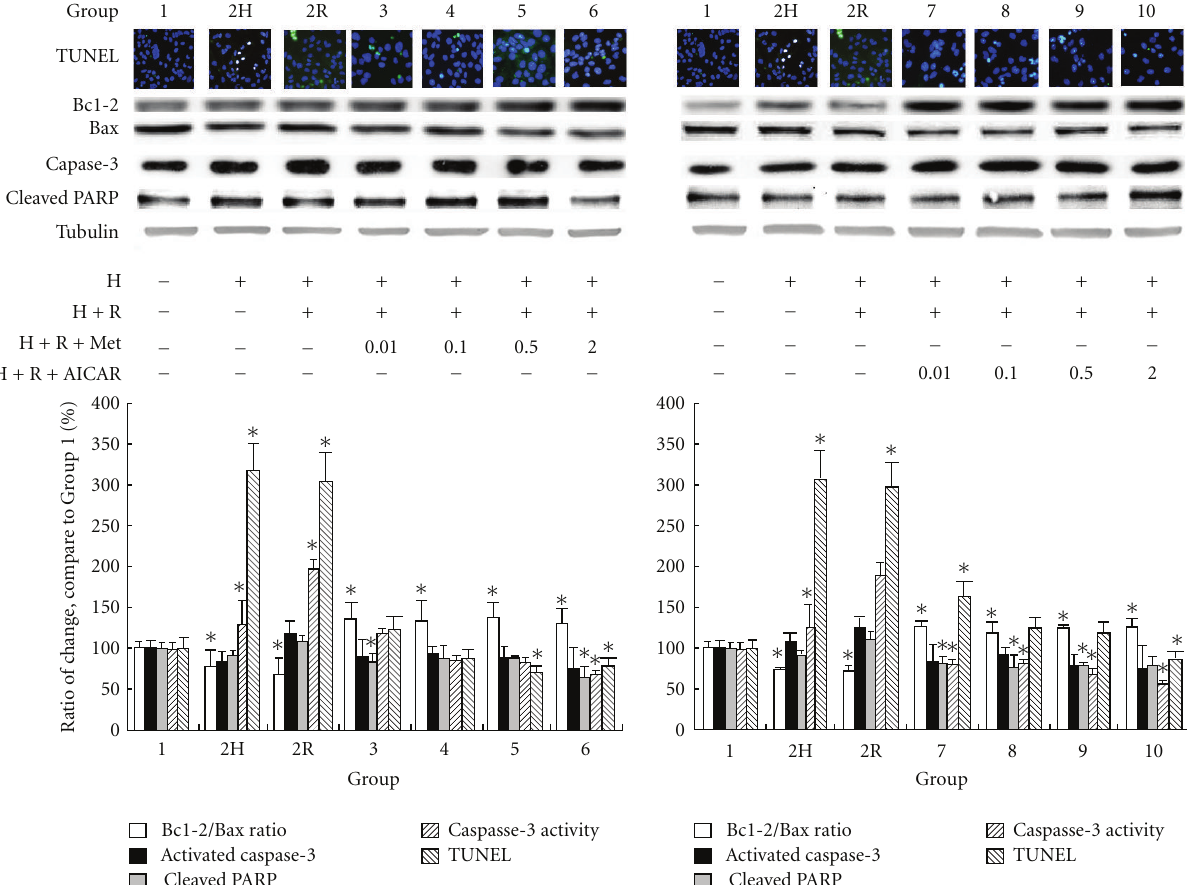
Figure 4: E ff ect of AMPK activation on cardiomyocytic apoptosis after cardioplegia-induced H/R injury. The percentage of apoptotic nuclei in di ff erent groups was determined by staining with terminal deoxynucleotidyl transferase-mediated dUTP-biotin nick end labeling (TUNEL). Protein levels of Bcl-2/Bax ratio, activated caspase-3, and cleaved poly-(ADP-ribose) polymerase were determined in the di ff erent groups by western blot analysis. Caspase-3 activity was also evaluated. (Results are representative of at least 3 separate experiments. ∗ P < . 05 compared with Group 1; H: hypoxia; R: reoxygenation; Met: